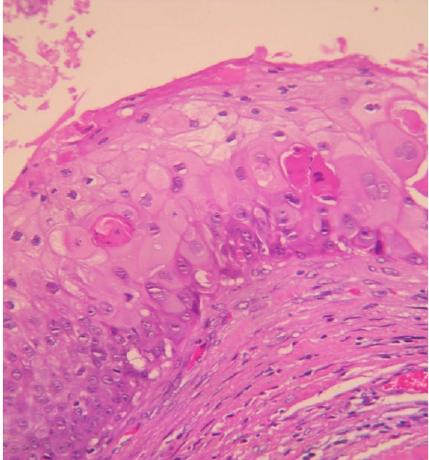
Figure 4: High magnification micrograph showing squamous epithelium keratinization (H and E, ×